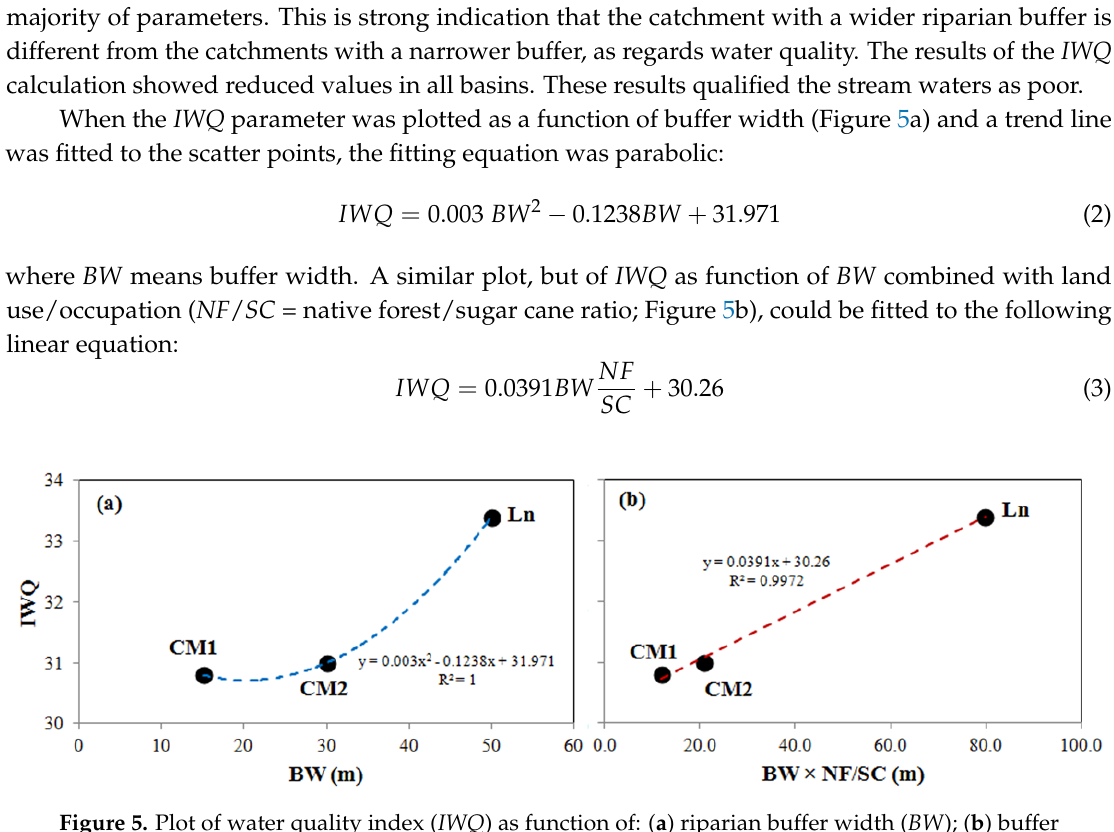
Figure 5. Plot of water quality index ( IWQ ) as function of: ( a ) riparian buffer width ( BW ); ( b ) buffer strip width combined with native forest/sugar cane ratio ( BW × NF/SC ). The points represent the values of IWQ versus BW or IWQ versus BW × NF/SC in the Mangabeira 1 (CM1), Mangabeira 2 (CM2) and Lanhoso (CLn) sub-basins.